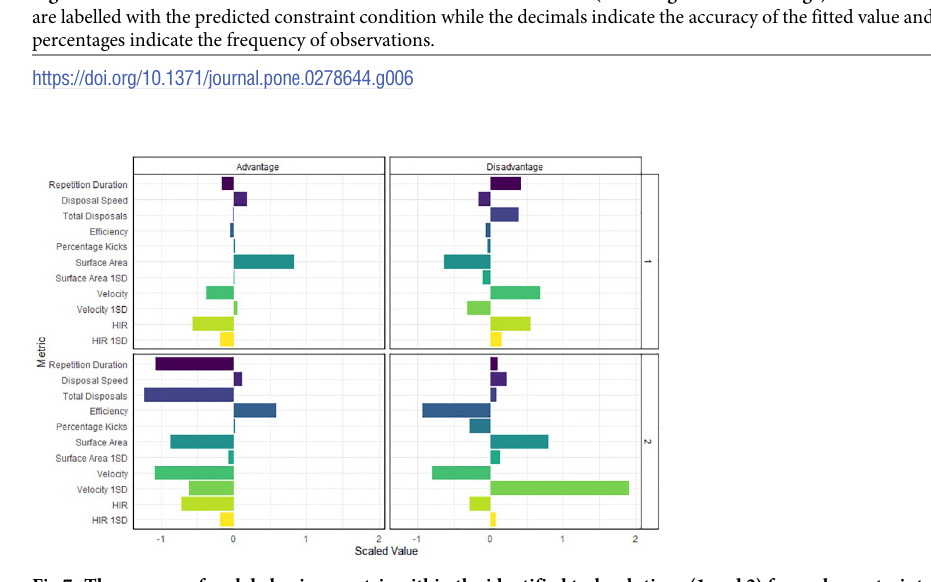
Fig 7. The average of each behaviour metric within the identified task solutions (1 and 2) for each constraint condition (advantage and disadvantage). The bar plot values are scaled to a mean of zero and a standard deviation of one to allow comparability between